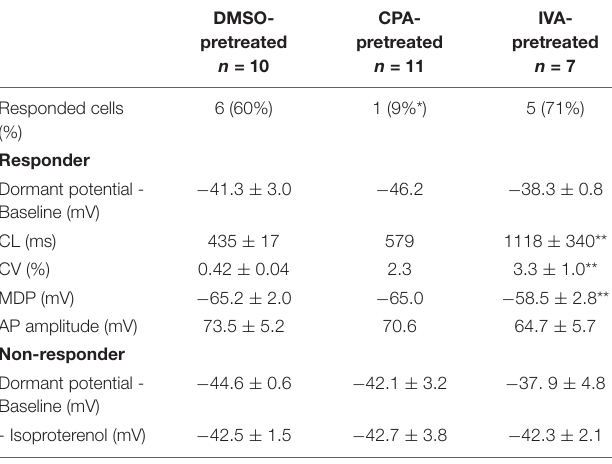
TABLE 2 | Membrane potential characteristics of CPA/IVA-pretreated dormant SANC in response to β -AR